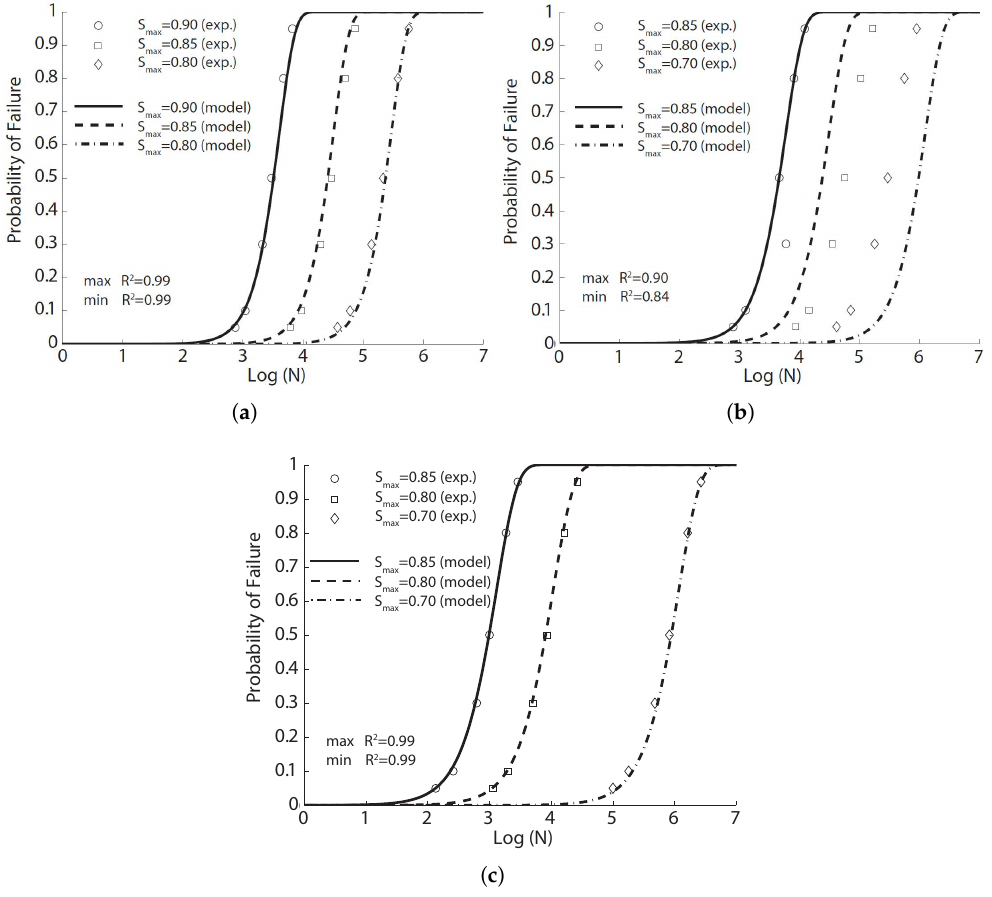
Figure 6. Comparison of the flexural fatigue data of Singh et al. [42] with the fitted probabilistic model Equation (8) for SFRC with volume ratios of ( a ) 1%; ( b ) 1.5% and ( c ) 2%, with 35% of long fibers and 65% of short